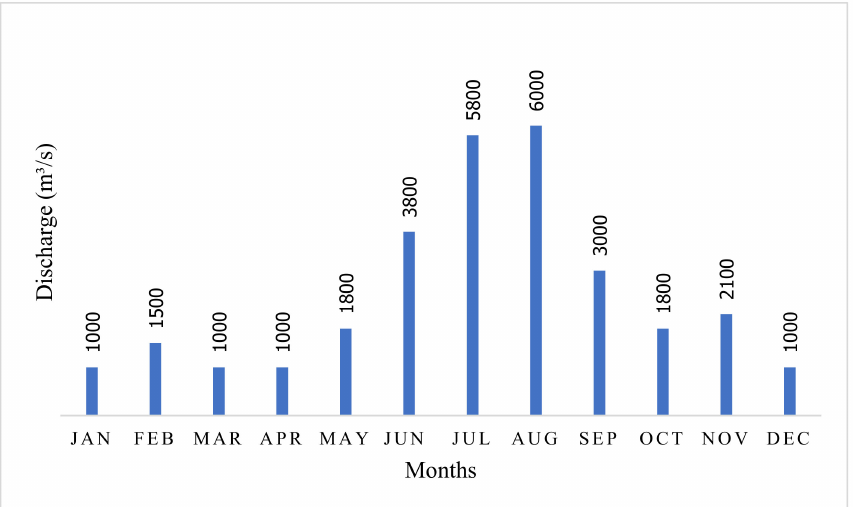
Figure 4. Mean monthly monsoon discharge with an entire annual monsoon duration during the time period of 1980–2017. The highest peak was observed from July to August due to glacier melting and monsoon rainfall. The flow rate during the post-monsoon period (September to December) increases compared to pre-monsoon period (January to May) because of a shift in temperature melting glaciers at the end of the monsoon